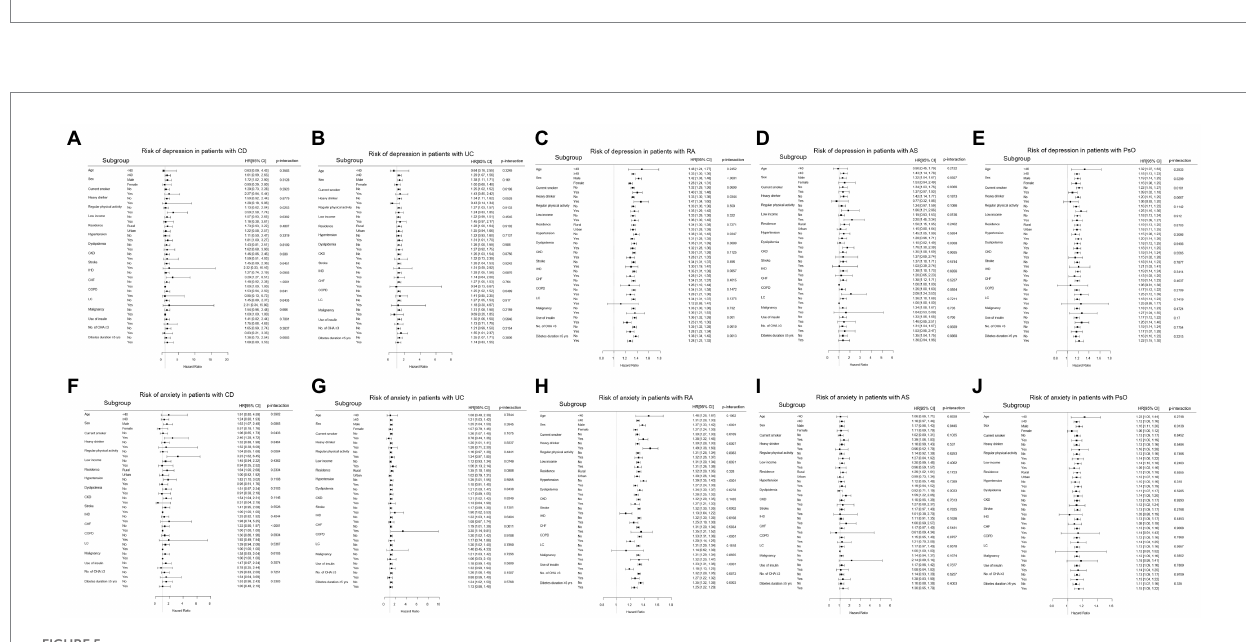
FIGURE 5 Subgroup analyses for the risk of depression in patients with (A) CD, (B) UC, (C) RA, (D) AS, and (E) PsO; and the risk of anxiety in patients with (F) CD, (G) UC, (H) RA, (I) AS, and (J) PsO. CD, crohn’s disease; UC, ulcerative colitis; RA, rheumatoid arthritis; AS, ankylosing spondylitis; PsO, psoriasis; CKD, chronic kidney disease; IHD, ischemic heart disease; CHF, congestive heart failure; COPD, chronic obstructive pulmonary disease; LC, liver cirrhosis; OHA, oral hypoglycemic